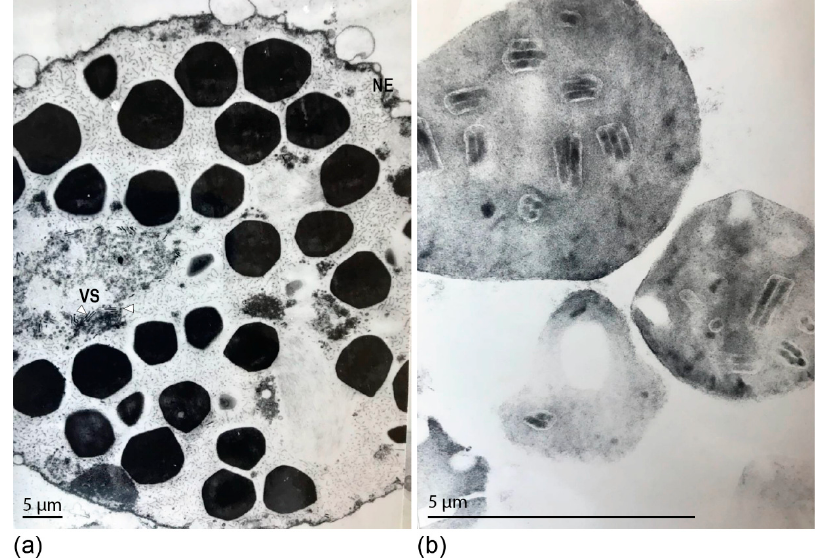
Figure 1. Ultrastructural analysis of the Dione juno nucleopolyhedrovirus (DijuNPV) occlusion bodies (OBs). ( a ) Passionfruit caterpillars were fed on contaminated passionfruit leaves, and when the first symptoms of infection appeared, the insects were frozen and dissected for fat body extraction. The tissue was fixed and prepared for transmission electron microscopy. A section of a single cell inset on the nucleus is presented here. The nuclear envelope (NE) surrounds several polyhedral OBs. The virogenic stroma (VS) presents non ‐ enveloped rod ‐ shaped nucleocapsids (white arrowhead). ( b ) Cross section of a purified DijuNPV OB showing several occlusion ‐ derived viruses containing multiple nucleocapsids.